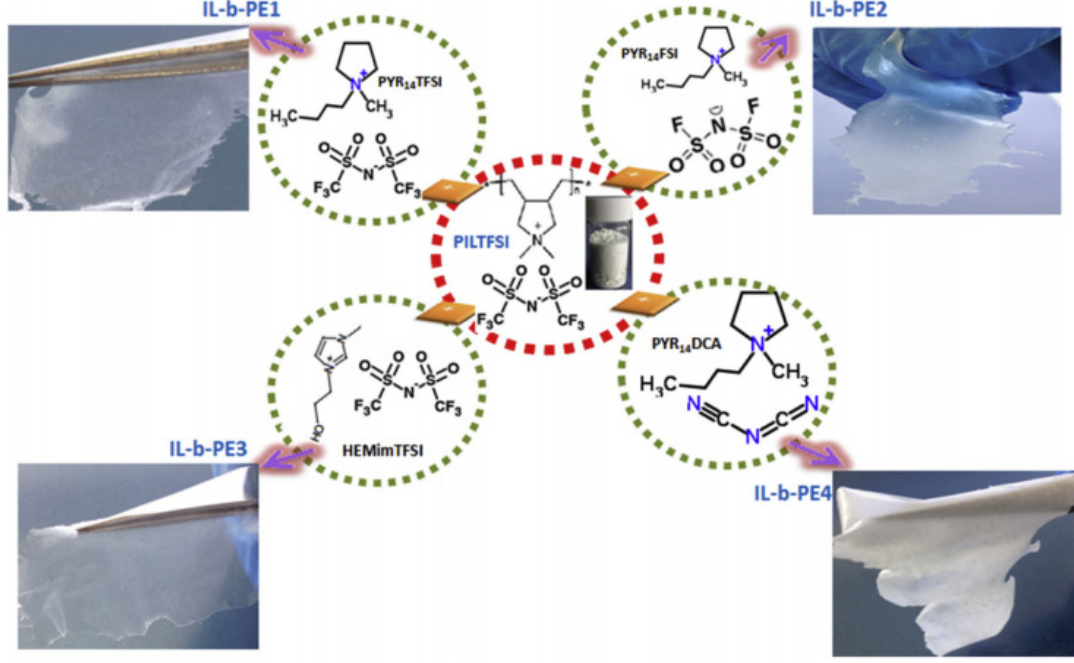
Figure 17. Chemical structure of [PIL][TFSI] and different ILs ([Pyr 14 ][TFSI], [Pyr 14 ][FSI], [Pyr 14 ][DCA], and [HEMI][TFSI] and the respective photo for each membrane. Reprinted 2016 from [99] with permission from Elsevier.